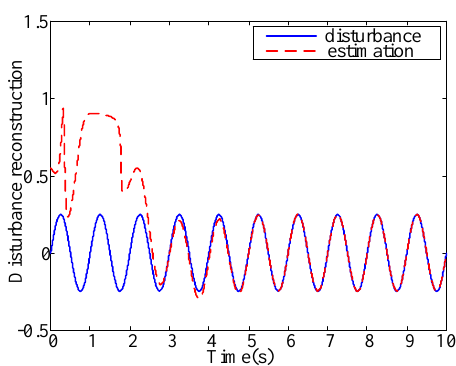
Figure 4. Continuous input recovery by SMO.